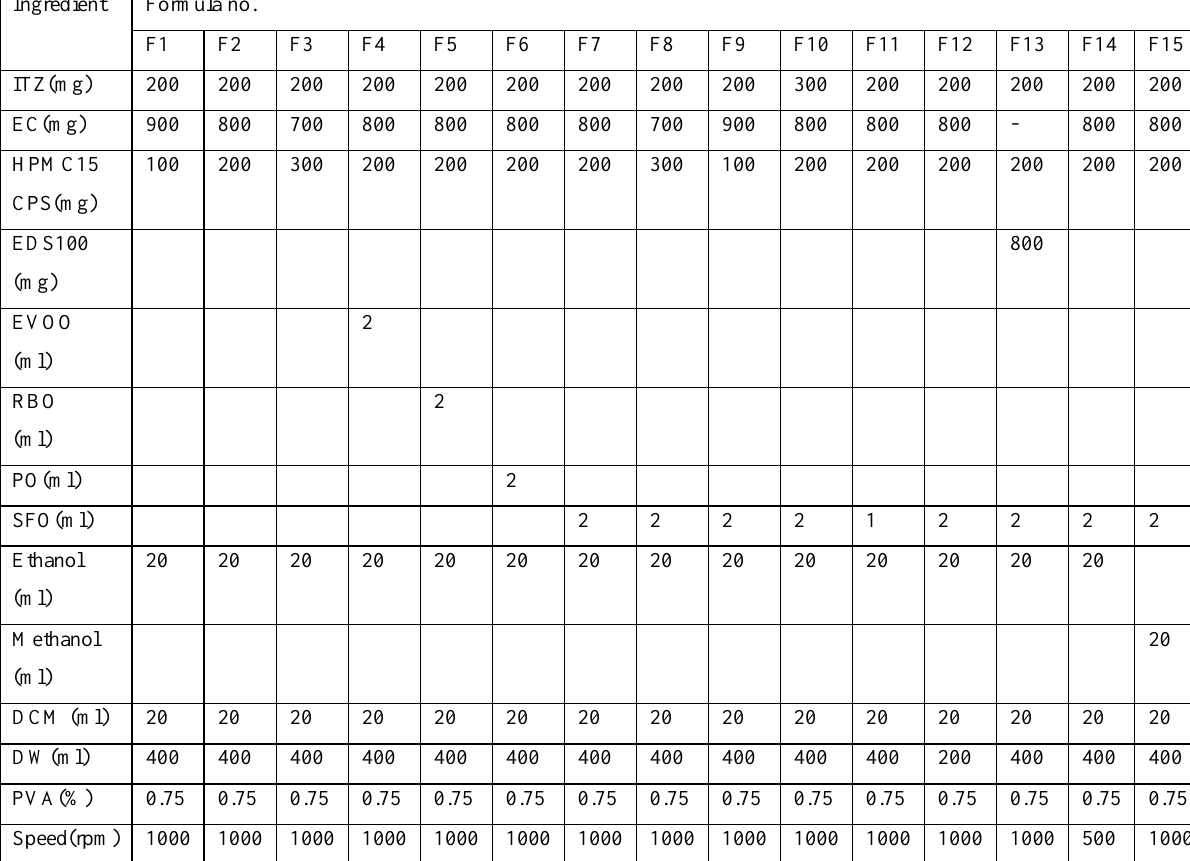
Table 1.Composition of ITZ floating microparticles